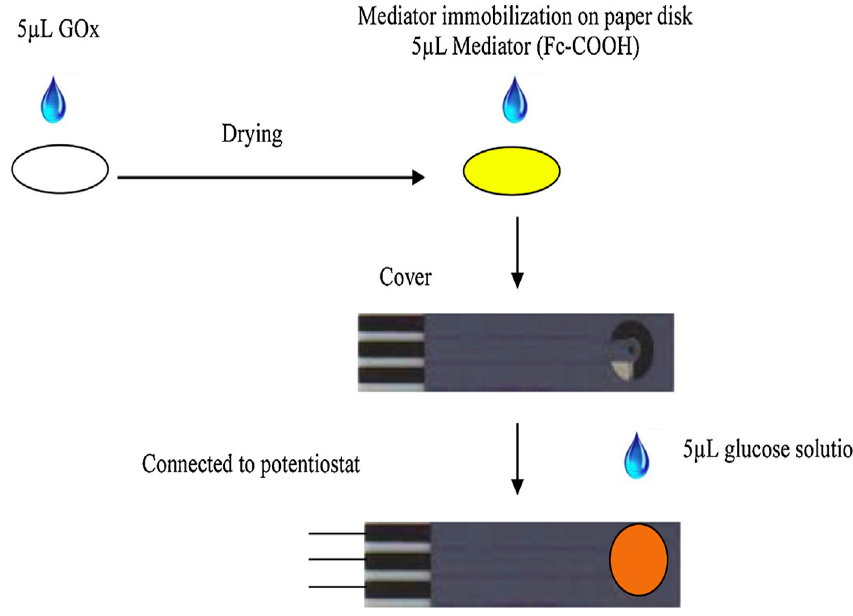
Figure 15. Preparation of paper disk and integration with SPCE [119].